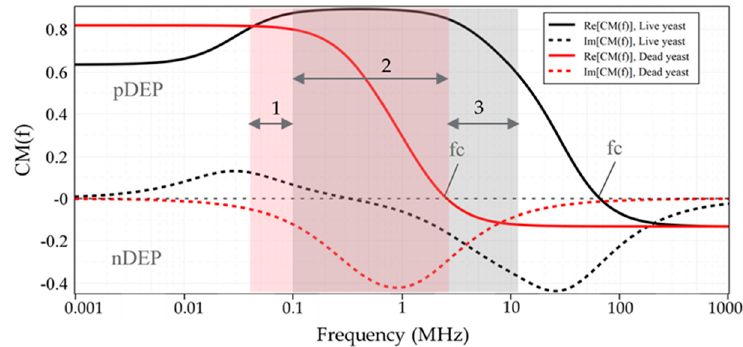
Figure 9. Experimentally measured (pink and gray zones) and numerically predicted (lines) affective pDEP for live and dead cells in 0.0002 S/m DIW at different AC field frequencies at the microfluidic channel using pDEP.